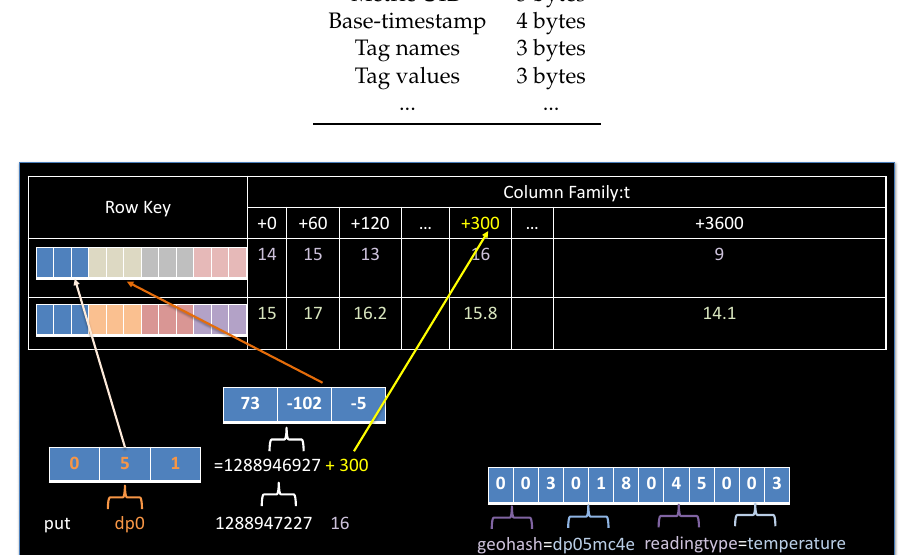
Figure 5. OpenTSDB tsdb